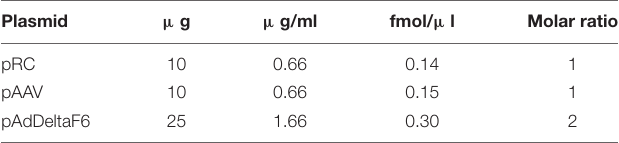
TABLE 1 | DNA amount for AAV